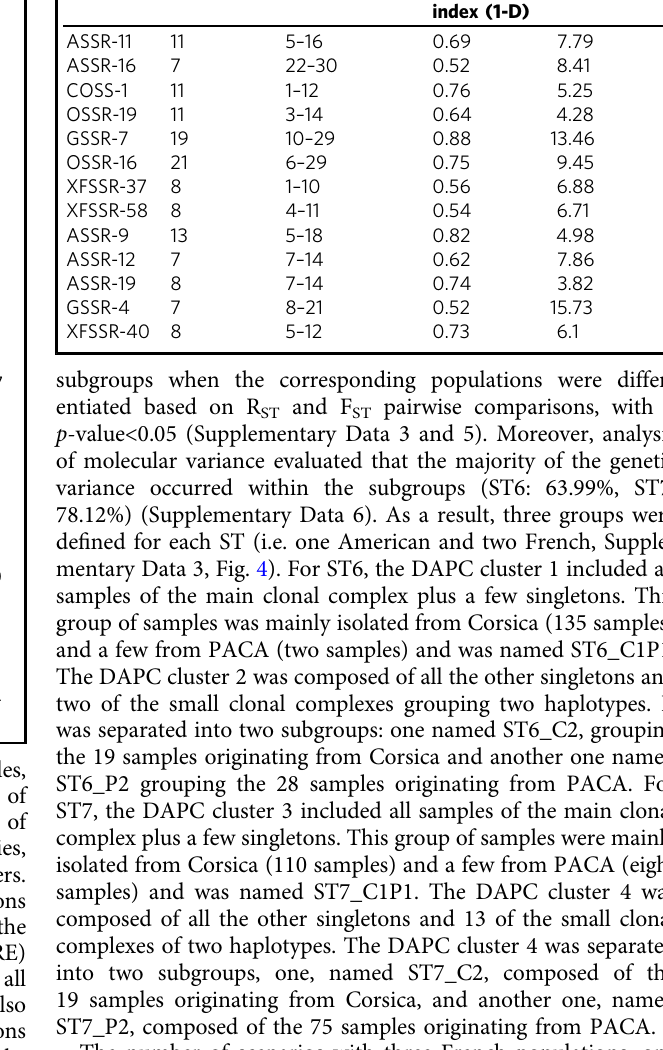
Table 2 Characteristics of the 396 French strains and plant samples used in this study. Corsica PACA Total Acacia